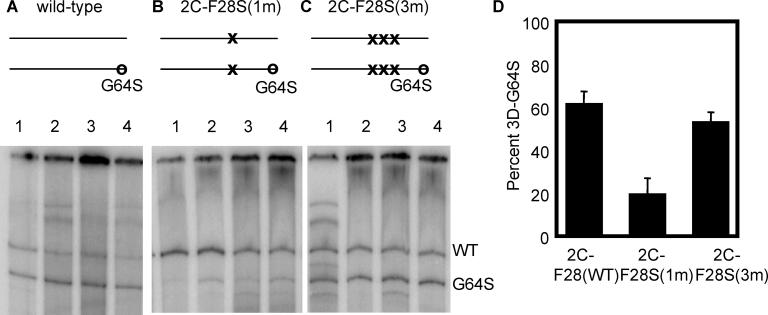
Viral Competition Assay in the Context of the 2C-F28S Temperature-Sensitive Attenuating MutationsMuscle tissue from the experiment shown in Figure 6 was processed and the BstBI digestion assay was performed. Representative gels of digestion products, with maps indicating the mutations at the 2C locus are shown: (A) wild-type, (B) 2C-F28S(1m), (C) 2C-F28S(3m). (D) Quantitation of the gels in A–C. The percent 3D-G64S is shown, and represents an average from 5–10 mice for each condition.DOI: 10.1371/journal.ppat.0010011.g007